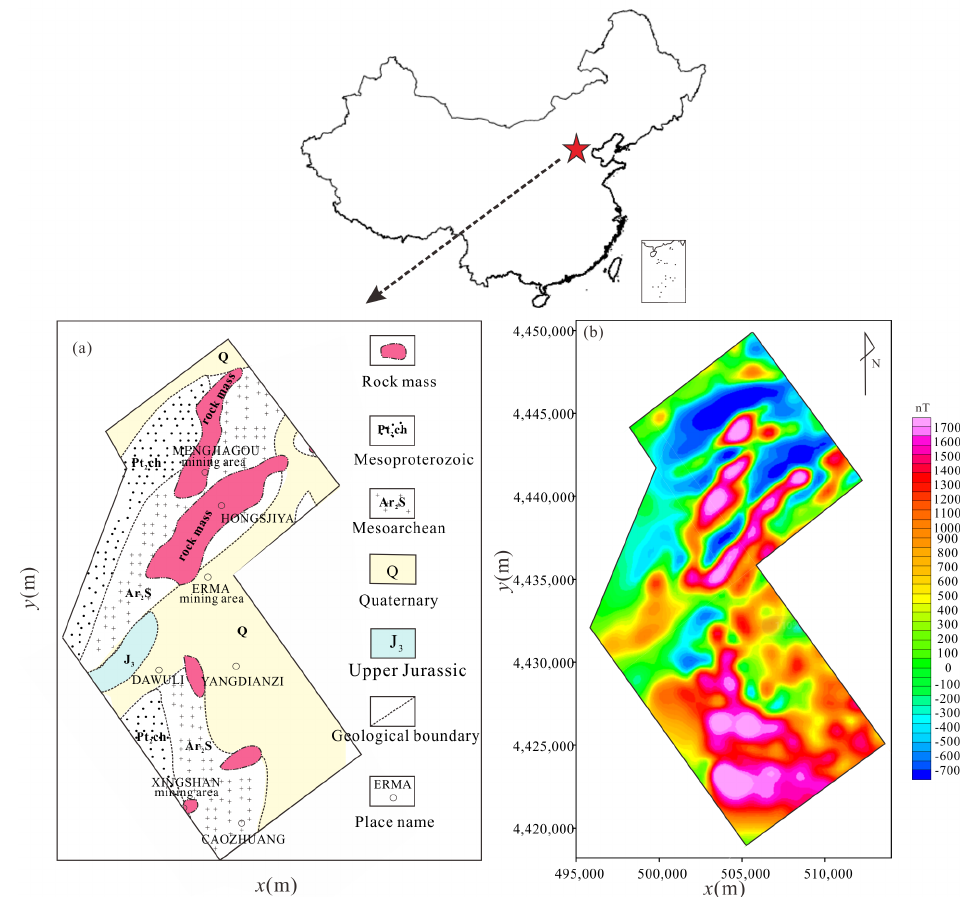
Figure 8. ( a ) Regional geology map of survey area; ( b ) measured magnetic